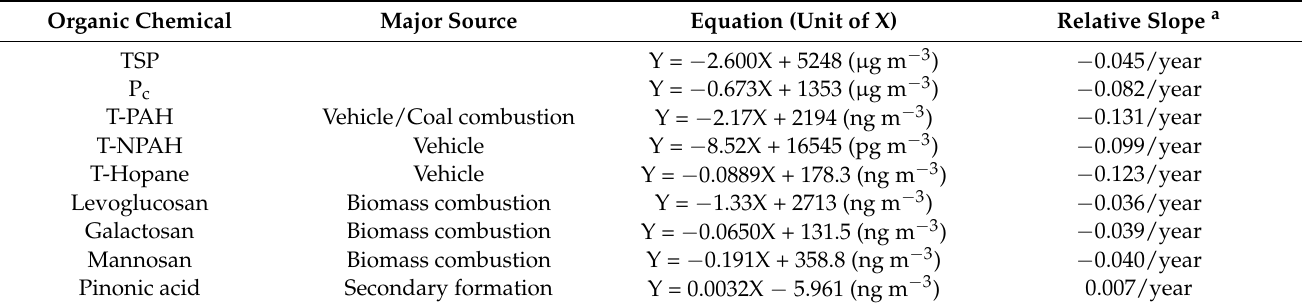
Figure 5. Atmospheric levoglucosan, galactosan, mannosan, and pinonic acid concentrations in Sapporo from 1990 to 2002 by season. Table 3. Parameters of the first-order linear regression equation for the source